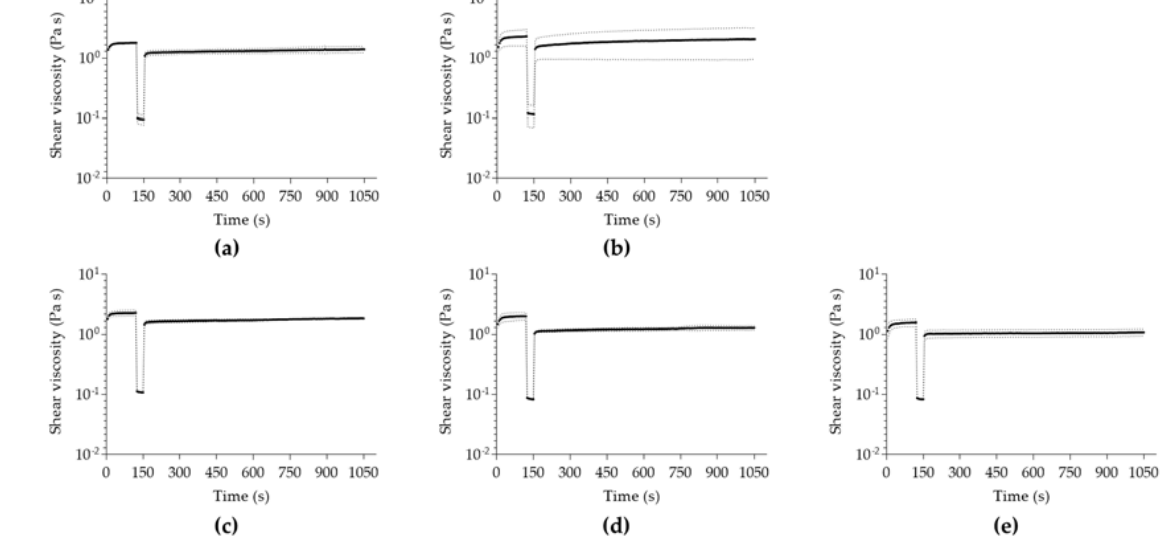
Figure 4. Thixotropy analysis of ( a ) alginate/fucoidan, ( b ) menthol-alginate/fucoidan, ( c ) linalool- alginate/fucoidan, ( d ) bergamot-alginate/fucoidan, and ( e ) pinene-alginate/fucoidan. Data expressed as mean ± SD of n = 3 different hydrogel batches.